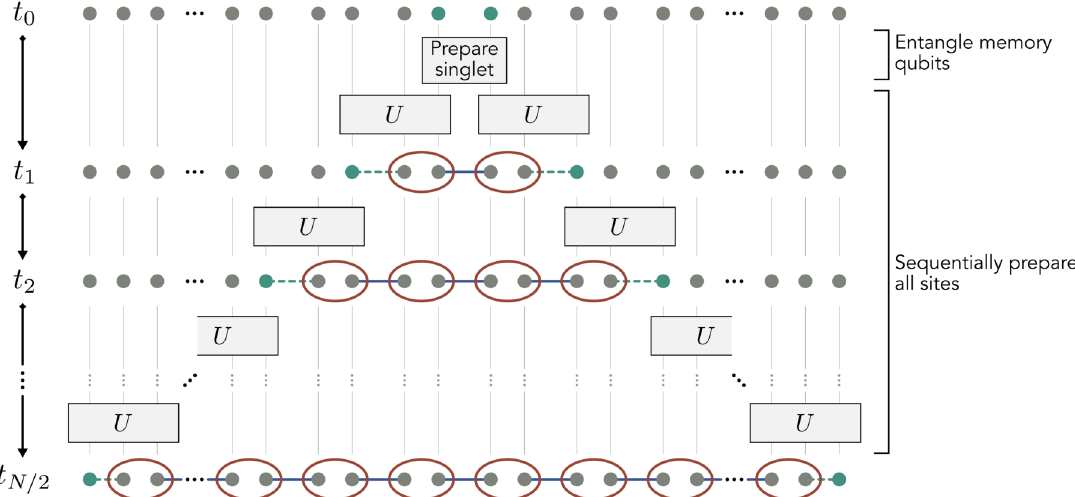
FIG. 2. Sequential preparation of the AKLT state with a linear depth circuit. Each time step consists of applying the site prepara- tion unitary U to two qubits composing a spin-1 site (gray circles) and a memory qubit (green circles). The latter is responsible for propagating correlations between spin-1 sites. To reduce the overall circuit depth, our sequential procedure takes advantage of spatial inversion symmetry to grow the AKLT state simultaneously at both ends, using the two memory qubits in